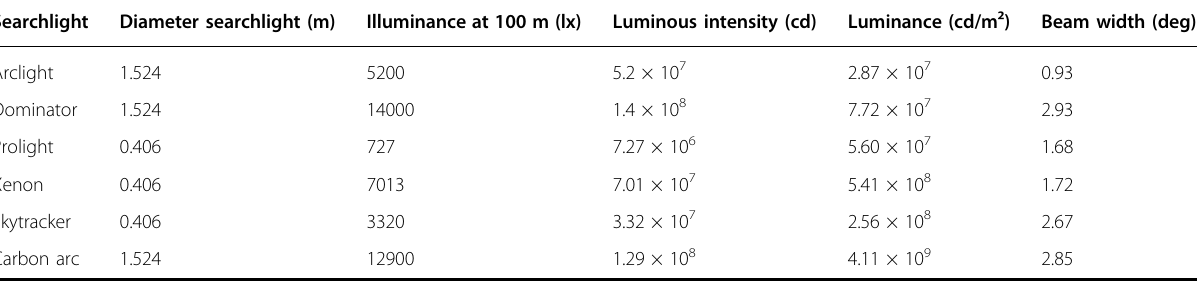
Table 1 Lighting characteristics/parameters of various high-intensity lights/technologies 63